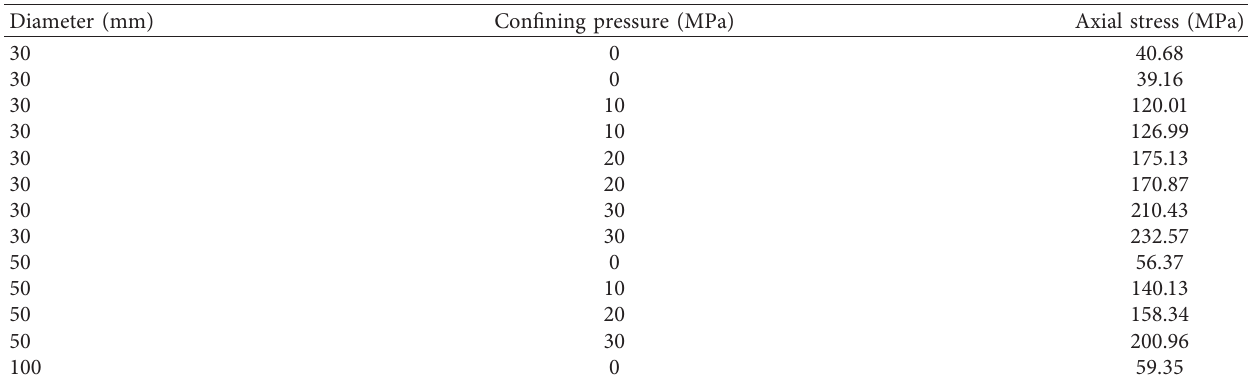
Figure 2: LVDTsensor calibration data. (a) Horizontal LVDTsensor calibration data (red line indicates the linear range). (b) Vertical LVDT sensor calibration data (red line indicates the linear range). Table 1: Results from compression experiments of sandstone